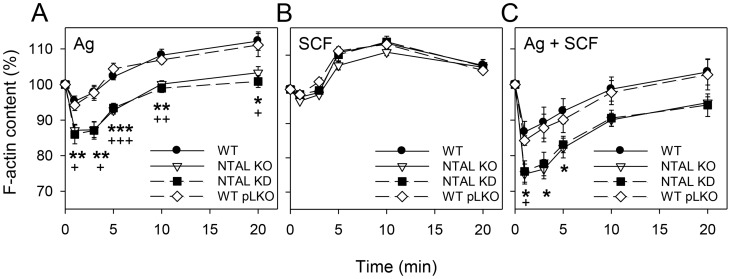
BMMCs with NTAL KD exhibit enhanced actin depolymerization after stimulation with Ag or Ag + SCF.Cells were activated with Ag (250 ng/ml TNP-BSA; A), SCF (40 ng/ml; B) or Ag + SCF (C). At the indicated times, the cells were fixed, stained for F-actin with Alexa Fluor 488-phalloidin and analyzed by flow cytometry. Data were normalized to fluorescence of resting cells (similar in all cell types). Values indicate mean ± SE (n = 6). *,+
p<0.05; **,++
p<0.01; ***,+++
p<0.001; significant differences between NTAL KOs and WTs (asterisks) and NTAL KDs vs WT pLKOs (crosslets) are shown.